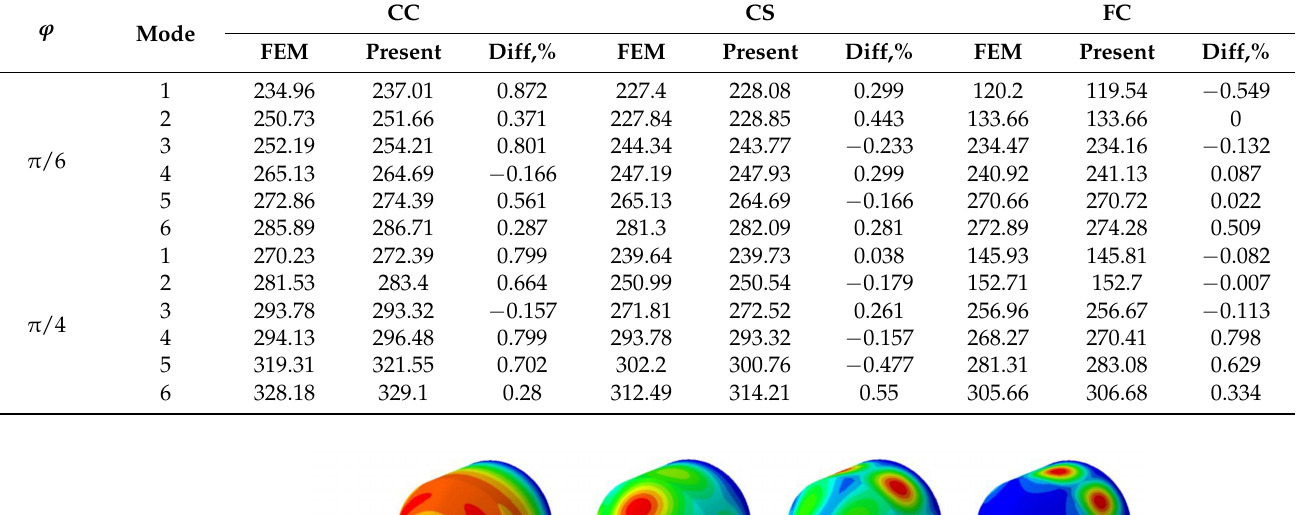
Table 4. Comparison of natural frequencies for non-rotating isotropic combined conical-cylindrical shell in thermal environment ( ∆ T = 50 K).